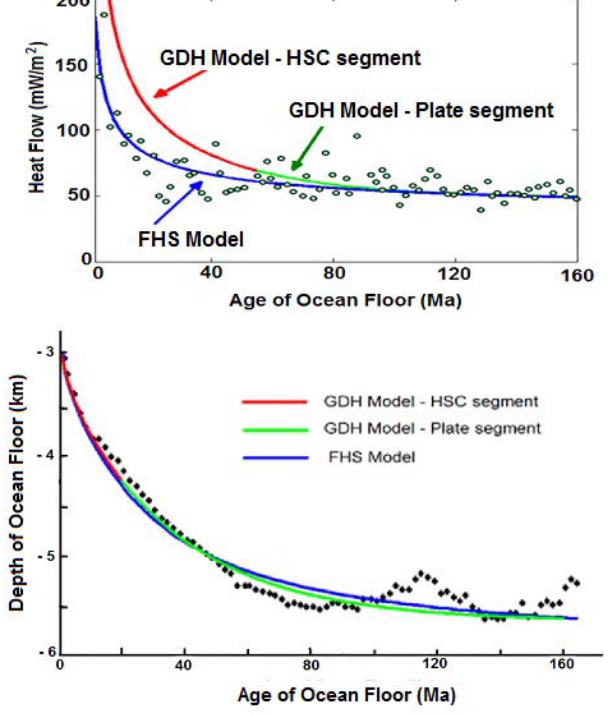
Fig. 3. Comparison of fits to observational heat flow (open circles in upper panel) and bathymetry data (closed circles in lower panel), by the global depth-heat flow (GDH) and finite half-space (FHS) models. The GDH model fit being a hybrid version is composed of two segments, derived from the half-space cooling (HSC) model (red curves) and plate model (green curves). The heat flow and bathymetry data are taken from Stein and Stein (1992).